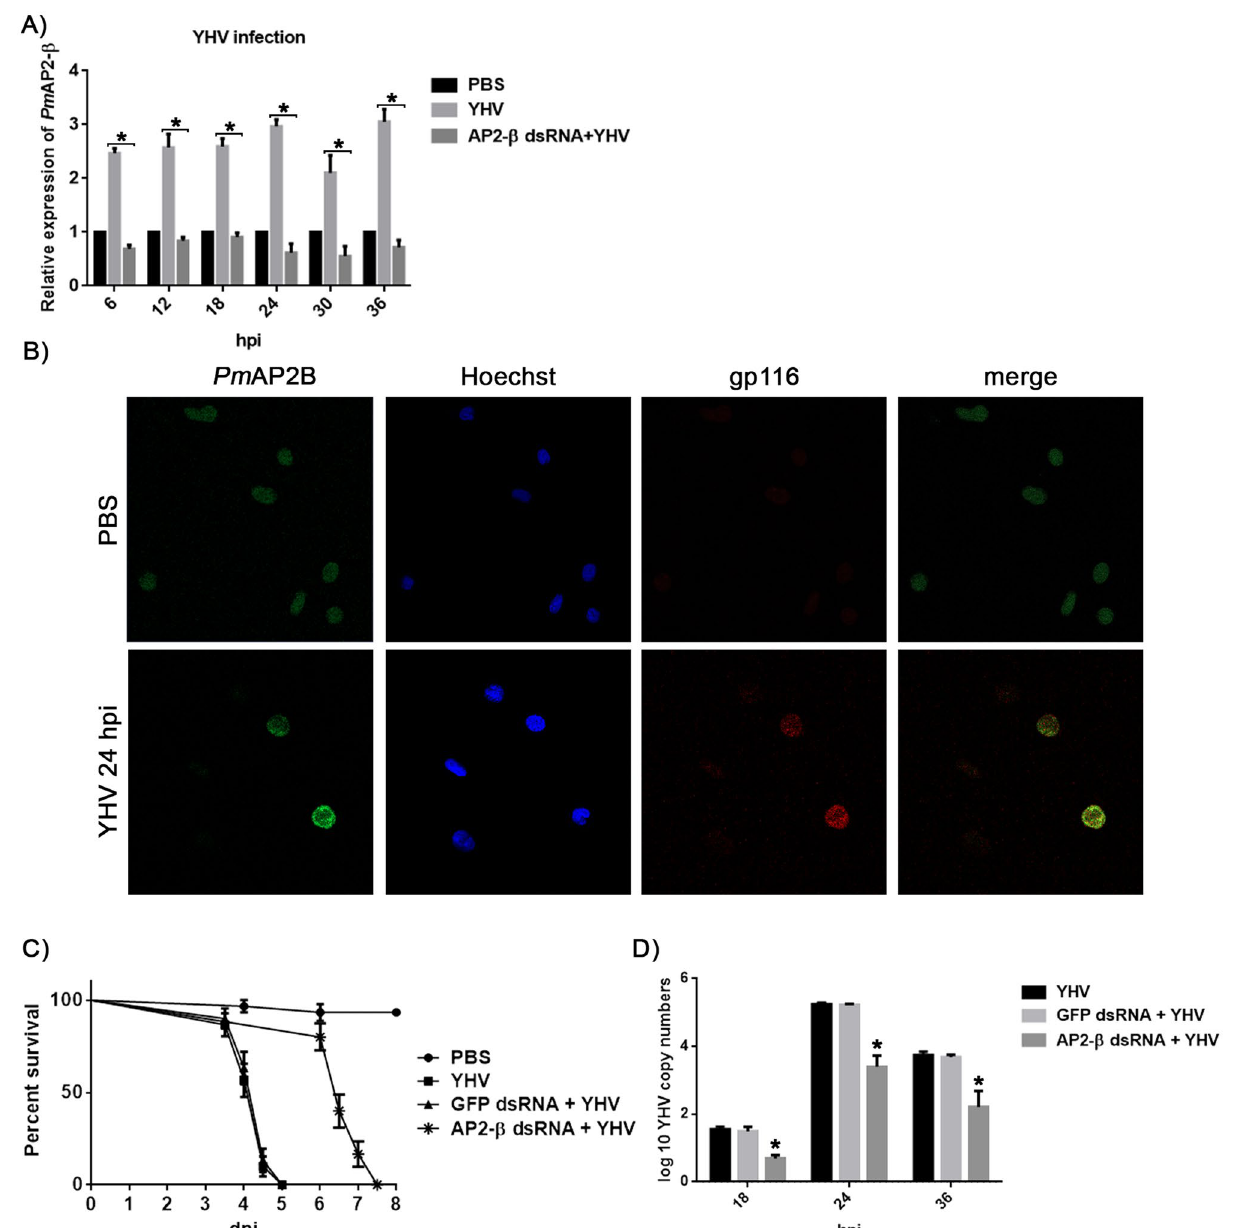
Figure 1. Expression of Pm AP2-β and effect of Pm AP2-β silencing on YHV infection. ( A ) The relative transcription levels of Pm AP2-β during YHV infection. The mRNA expression levels of Pm AP2-β were analyzed by Quantitative Real-time RT-PCR. The experiment was carried out in triplicate. ( B ) Expressions of Pm AP2-β (green) and gp116 (red) in the hemocytes of unchallenged and YHV-challenged shrimp were observed by confocal laser scanning microscopy. Secondary antibodies conjugated with Alexa Fluor 488 (green) and Alexa Fluor 568 (red) were used to probe anti-AP2-β and gp116 antibodies, respectively, while nuclei were stained in blue. ( C ) Effect of Pm AP2-β silencing on cumulative mortality caused by YHV. Shrimp were injected with either 150 mM NaCl or 10 µg GFP dsRNA per 1 g of shrimp or 10 µg Pm AP2-β dsRNA per 1 g of shrimp at 24 h prior to YHV challenge. The cumulative mortality was recorded every 12 h after YHV injection. Each group contains 10 shrimps. The experiment was carried out in triplicate. ( D ) Determination of YHV copy number in Pm AP2-β knockdown shrimp. Shrimp were divided into three groups and injected with either 150 mM NaCl, GFP dsRNA (10 µg/g shrimp), Pm AP2-β dsRNA (10 µg/g shrimp). Shrimp hemocytes were collected at 6, 12, 18, 24, 30 and 36 h after YHV injection for YHV copy number determination. The data are shown as the mean ± standard deviation. An asterisk represents significant differences from control group ( p < 0.05). The experiment was carried out in